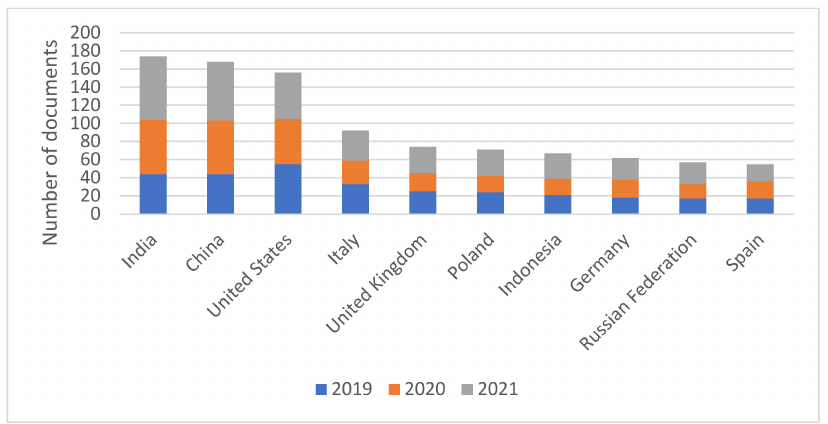
Figure 5. Evolutionary trends in renewable energy and agriculture publications from 2019 to 2021 for the top ten